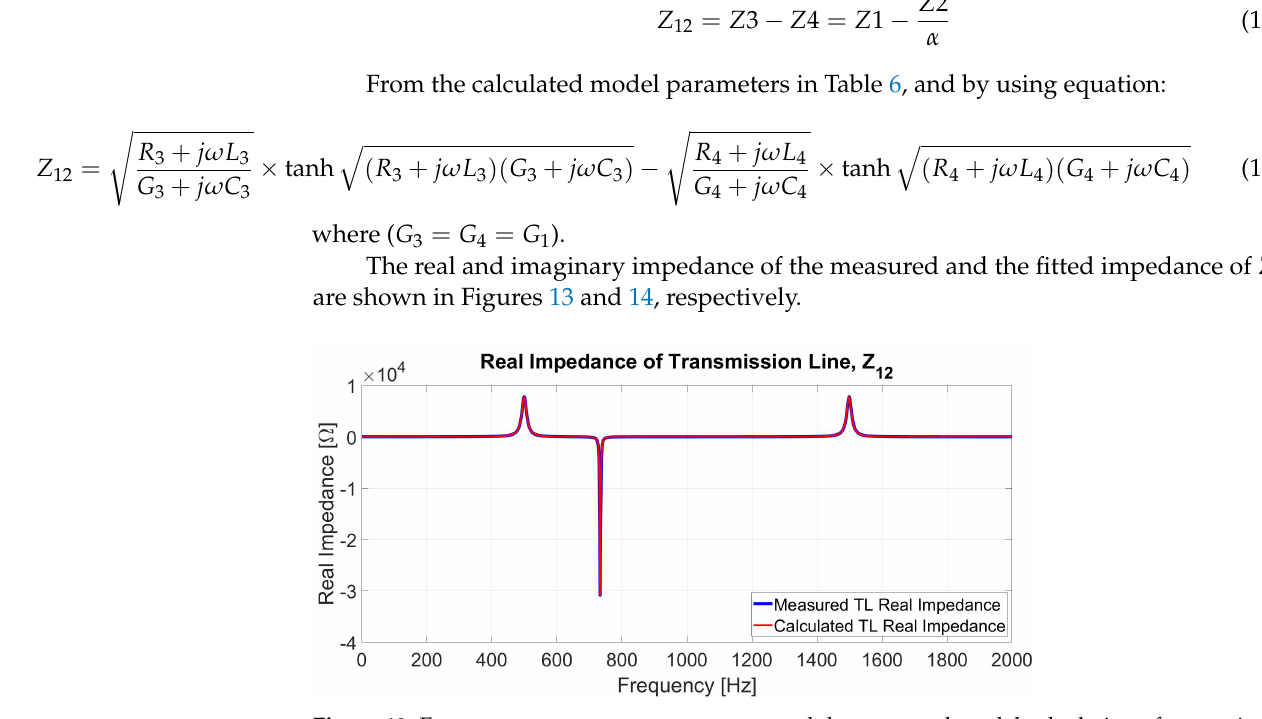
Figure 13. Frequency response measurements and the proposed model calculation of transmission line real impedance ( Z 12 ).